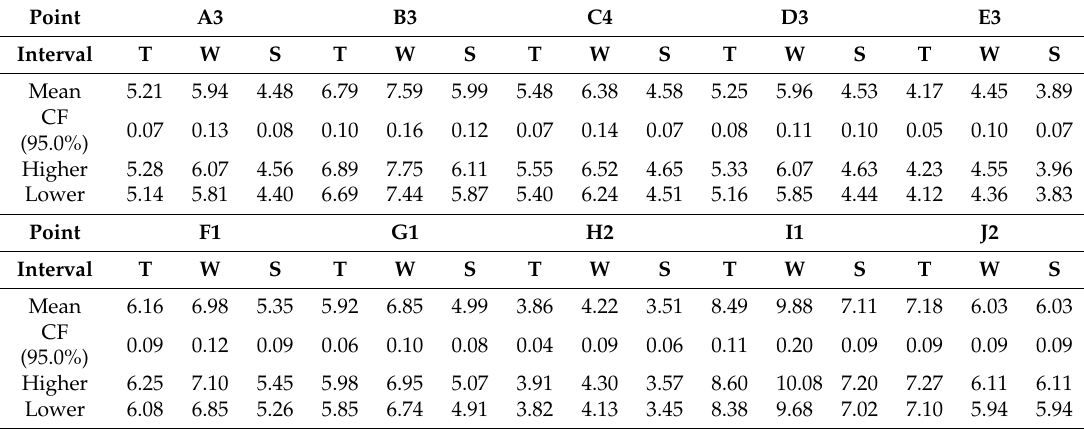
Table 2. Linear trend confidence levels (CF) of the average annual wind speed, computed for 10 reference points (one of each zone) considered as the most representative. Results corresponding to the 35-year time interval 1983–2017. CF represents the 95.0% confidence level.